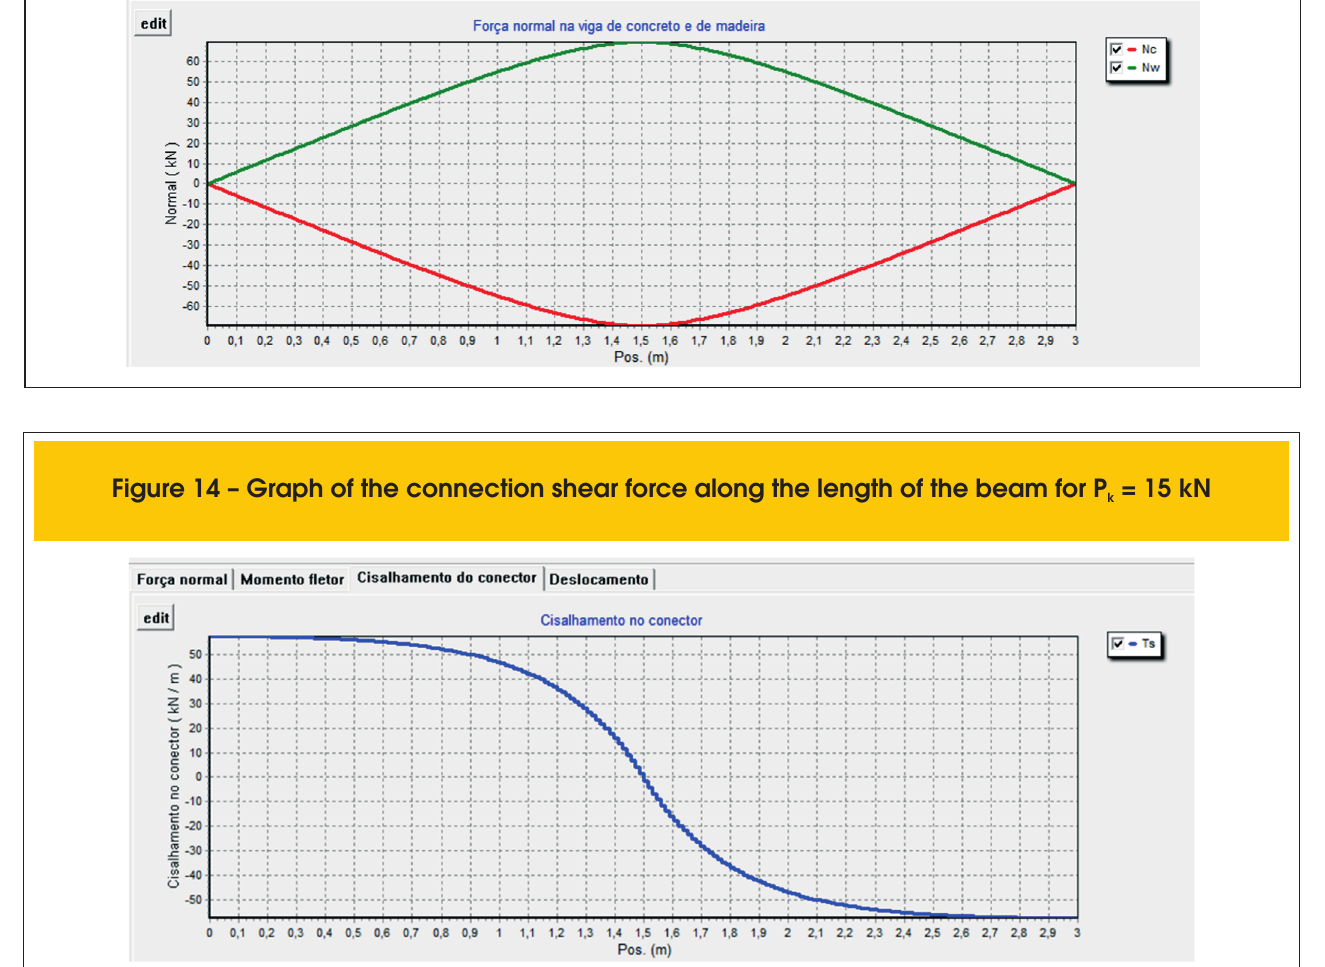
Figure 13 – Graph of normal forces on the concrete and timber beams for the applied force of P = 15 kN